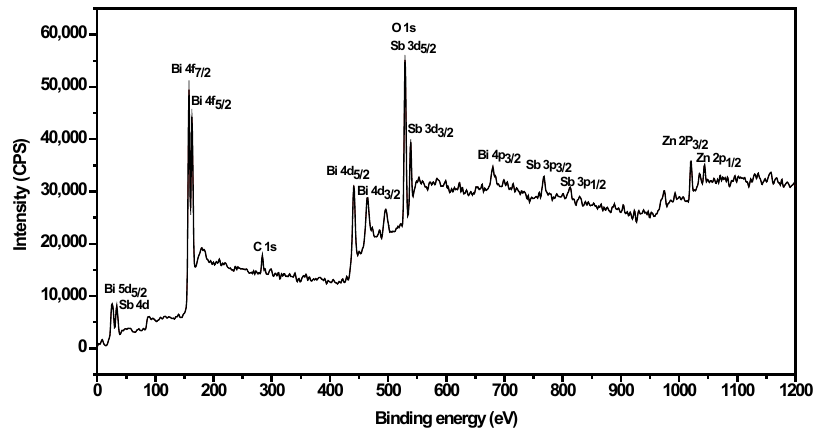
Figure 3. The X-ray photoelectron spectroscopy (XPS) full spectrum of ZnBiSbO calcinated at 800 °C for 35